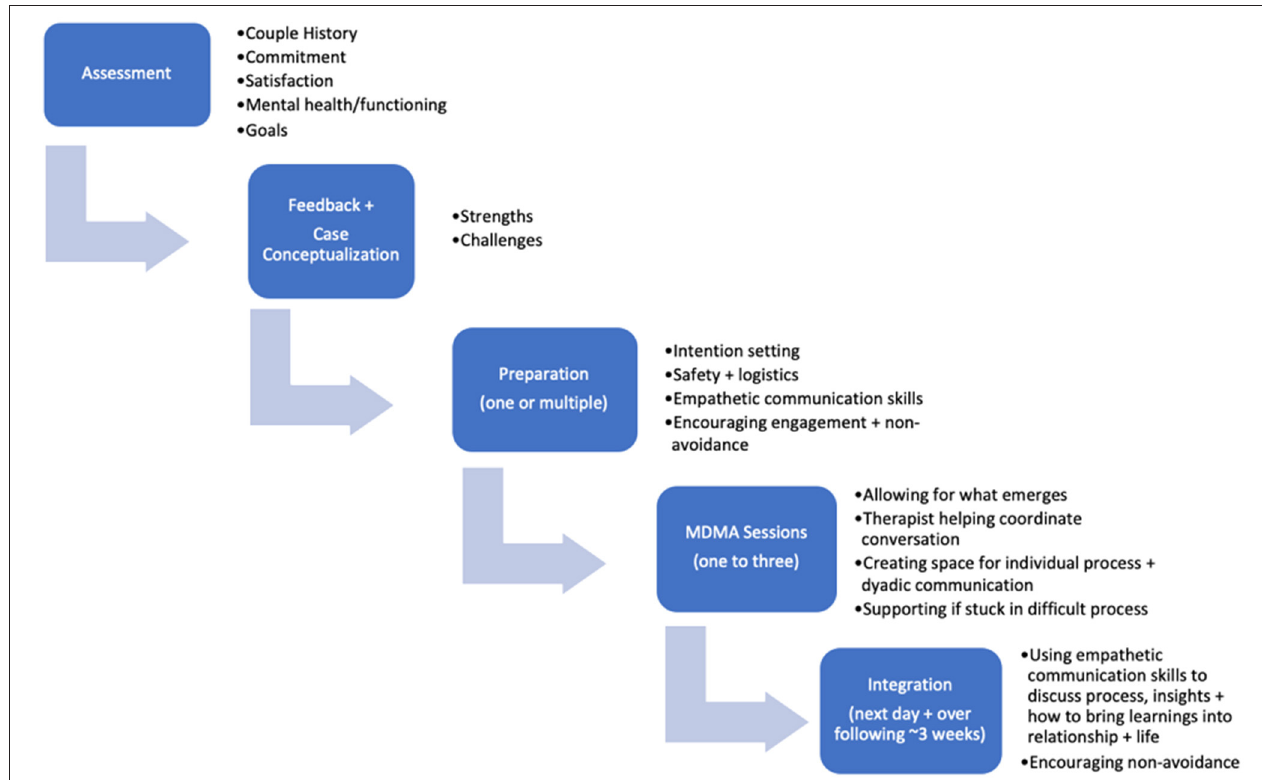
FIGURE 1 | MDMA-assisted couple therapy